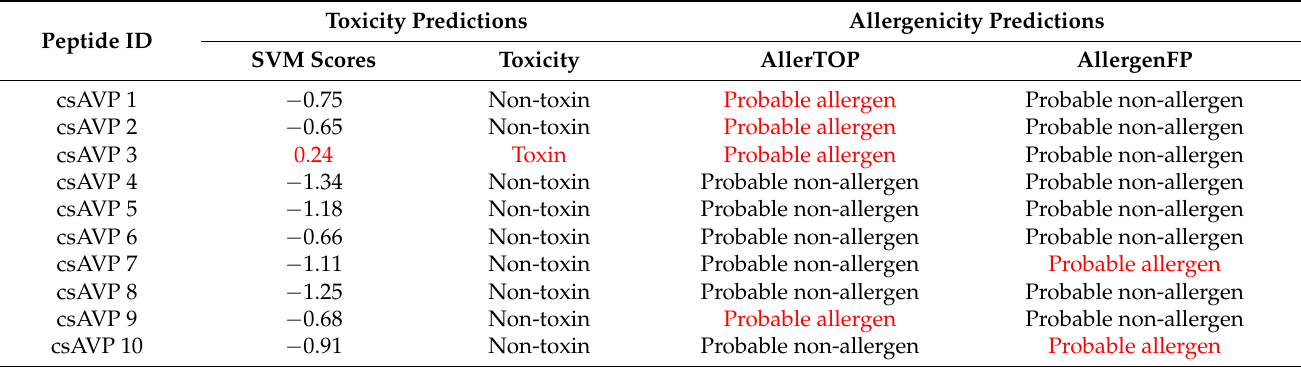
Table 4. Predictive probability in toxicity and allergenicity from ToxinPred, AllerTOP, and AllergenFP